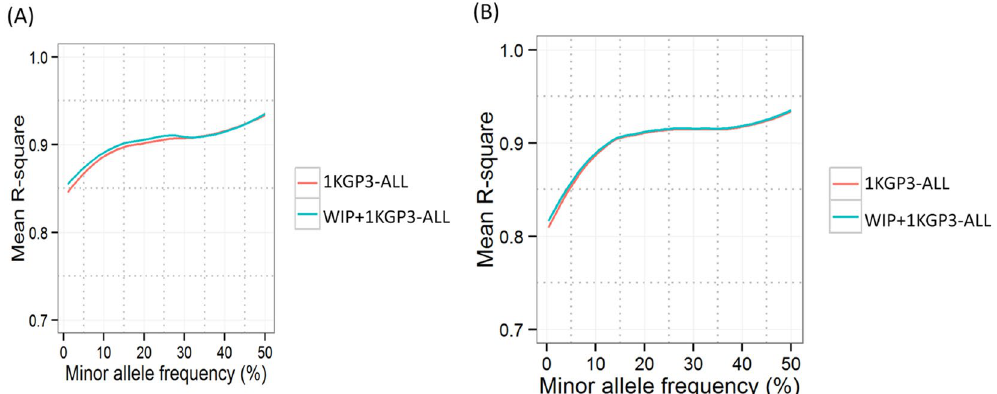
Figure 5. Comparison of imputation performance of data from other populations generated using 1KGP3-ALL and WIP + 1KGP3-ALL reference panels. The imputation performance of the reference panels, 1KGP3-ALL and WIP + 1KGP3-ALL was evaluated by comparing the imputed SNPs from other South Asian populations (Pathan and Sindhi from Human Genome Diversity Project (HGDP), and North-Indian individuals). ( A ) SNPs from HGDP data on Pathan and Sindhi populations (n = 48, 12494 SNPs) and ( B ) SNPs on North-Indian samples (13746 SNPs, n = 590). Results are restricted to chromosome 20 only. 1KGP3-ALL, The 1000 Genomes phase 3 reference panel; WIP + 1KGP3-ALL, merged panel of WIP and